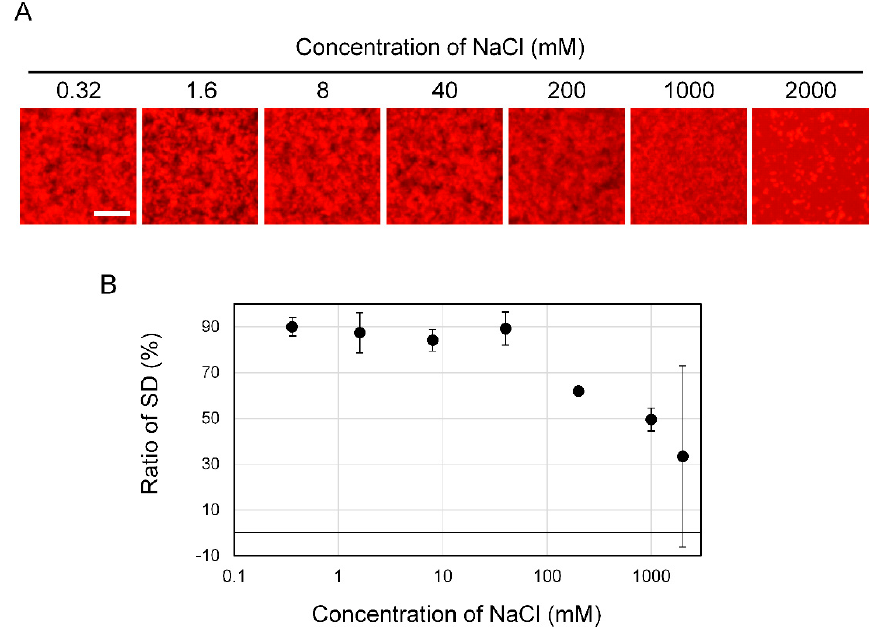
Figure 5. Influence of salt concentration on A β 42 aggregation. ( A ) NaCl solution adjusted to each concentration and the A β 42 solution were mixed then incubated for 24 h at 37 °C. Using the MSHTS system, the influence of NaCl concentration on the formation of A β 42 aggregates was examined. At 2000 mM NaCl, A β 42 and QDA β were salted out. From their morphology, it is believed that these solids were not A β 42 aggregates. At 1000 mM, aggregates started to form. At 40 mM or less, no significant effect was observed on the aggregates. From 40 to 0.32 mM, normal aggregates were formed. Bars: 100 μ m. ( B ) Ratio of SD value at each NaCl concentration. At 40 mM or less, the SD value was not affected by NaCl concentration.